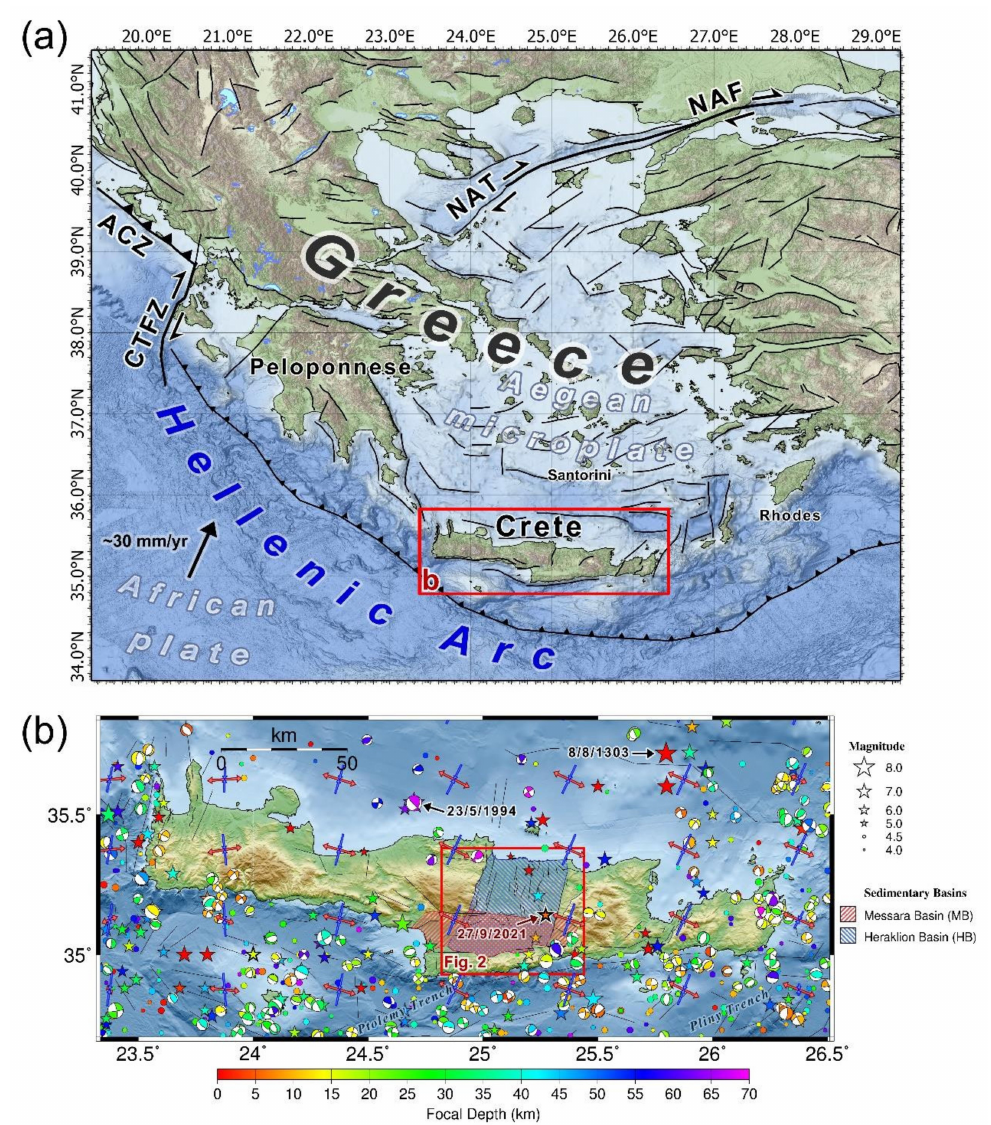
Figure 1. ( a ) Location of Crete (red rectangle) in southern Greece. Bold lines marked with dents or arrows indicate major tectonic structures in the vicinity of the Hellenic Arc; ACZ: Apulian Collision Zone, CTFZ: Cephalonia Transform Fault Zone, NAT: North Aegean Trough, NAF: North Anatolian Fault. Lines indicate the traces of seismogenic sources from the Euro-Mediterranean Seismic Hazard Model 2013 (ESHM13; [11]). The NNE-pointing vector at the lower-left indicates the direction and convergence rate of the Nubian plate [12]. ( b ) Seismotectonic map of Crete (red rectangle in panel ( a ). Black lines are active faults from the NOAfaults v3.0 database [13]. Beachballs indicate focal mechanisms of earthquakes ( M w ≥ 4.0) from the compilation of [14] and sources referenced therein (see also Data Availability). Circles ( M < 5.0) and stars ( M ≥ 5.0) represent past seismicity of years 1000–1899 (SHEEC; [15]) and 1900–2009 [16] for events with focal depths down to 70 km. The maximum (S 1 ) and minimum (S 3 ) principal stress axes of the regional crustal stress field [14]